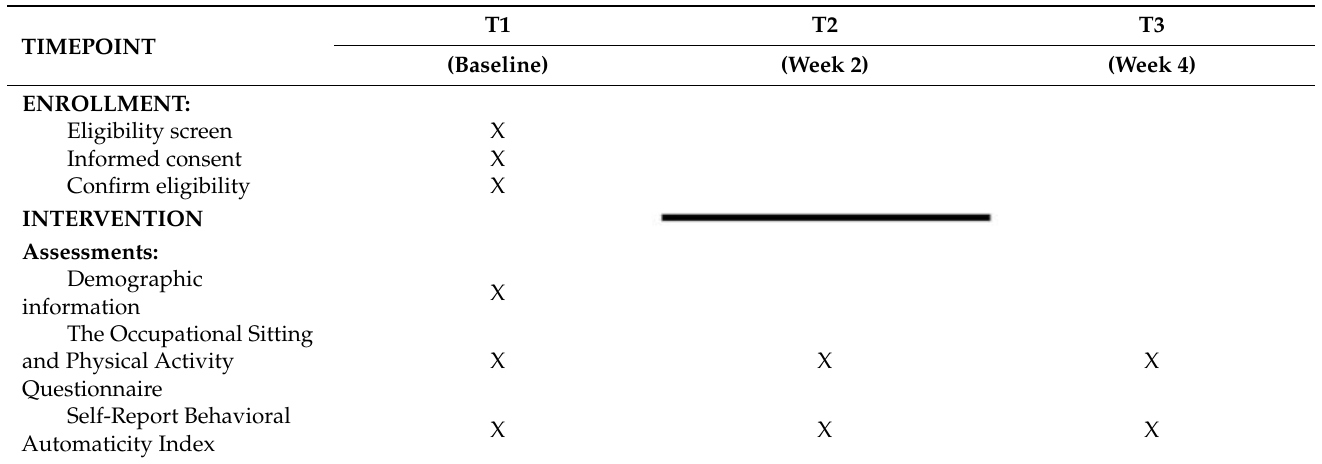
Table A1. SPIRIT Schedule Figure. Study timeline and data collection time